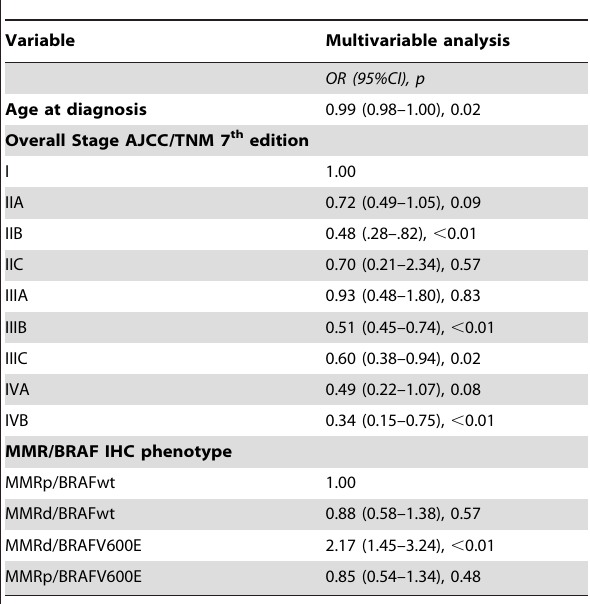
Table 2. Multivariable binary logistic regression showing adjusted effect of MMR/BRAF IHC phenotype on myc over- expression in 1421